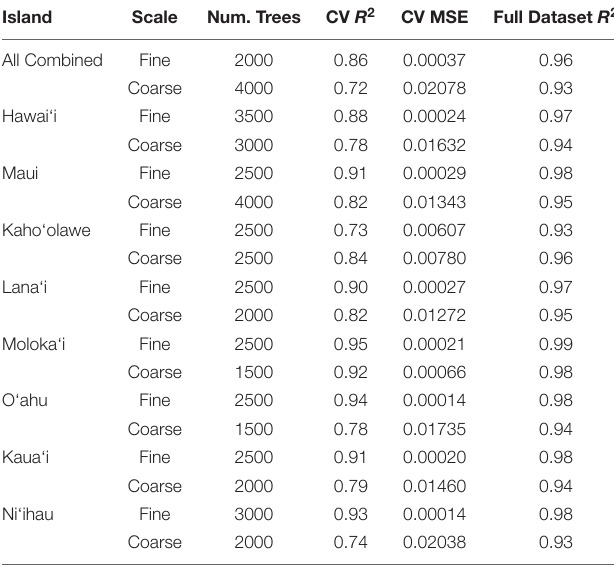
TABLE 2 | Optimized random forest metaparameters used in each individual and combined model from the land-sea driver modeling along with resulting